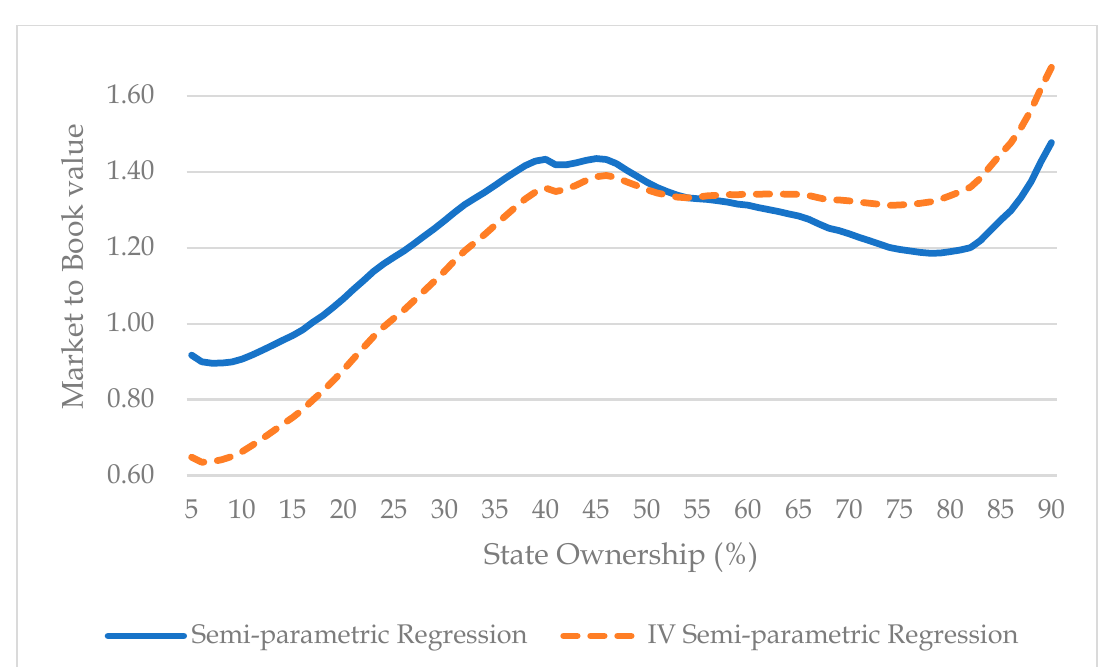
Figure A5. The marginal effect of state ownership (%) on partially privatized firm’s market to book value according to both semiparametric regression model and IV semiparametric regression model.